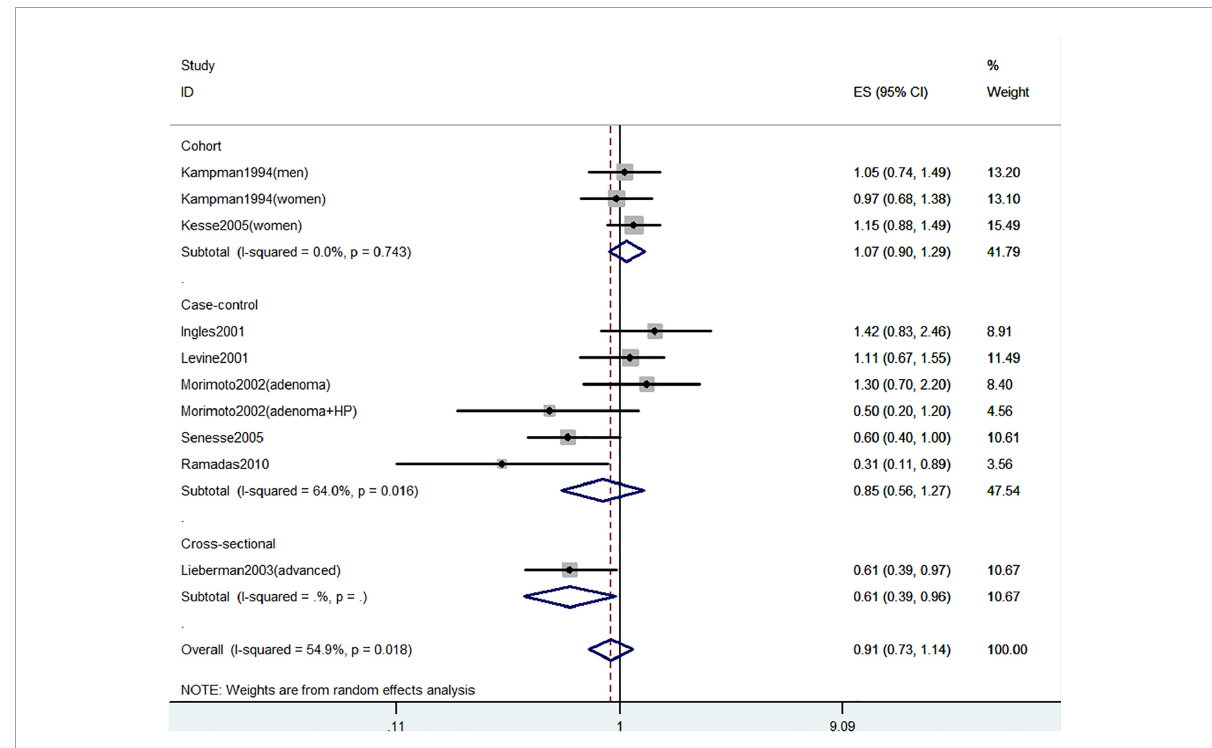
FIGURE3 Random-effects meta-analysis of studies that examined dietary vitamin D intake and risk of CRC precursors incidence. ES, effect size.